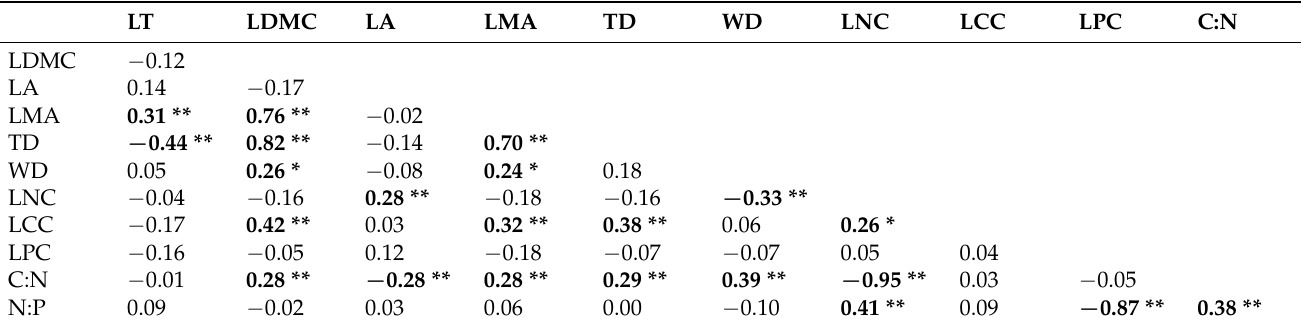
Table 4. Pearson correlation coefficient of 11 functional traits of L. fragrantissima var . lancifolia.